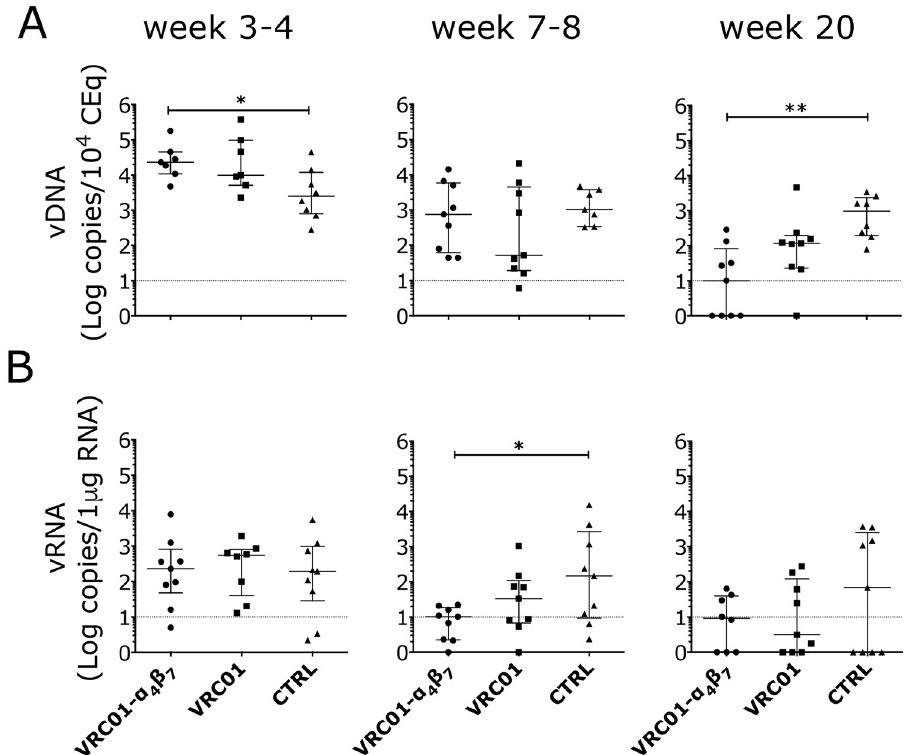
Fig 2. The Rh- α 4 β 7 -VRC01 combination reduces viral DNA and RNA in the gut. Copies of SIV DNA (A) and RNA (B) from colorectal biopsies at the indicated times after infection were quantified by gag -qPCR (normalized on albumin content) and by RT-qPCR (normalized on RNA content) respectively. Bars represent median ± IQR. The dotted line indicates the lower limit of detection (LLOD) of the assay. Data from the treatment groups were compared with the control by Kruskal-Wallis test and the results of the Dunn’s multiple comparisons post-hoc test are shown ( p - value of � α < 0.05 and �� α < 0.01 were considered significant).